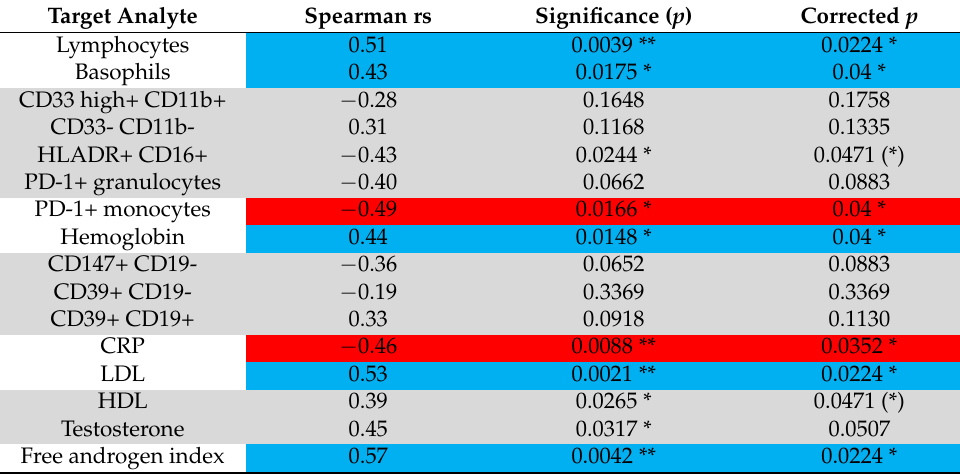
Table 6. Target analyte correlations with